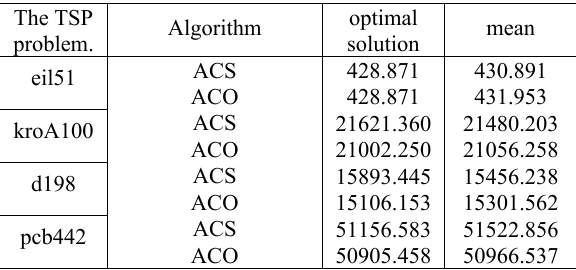
Table 9. Best results for algorithm on various